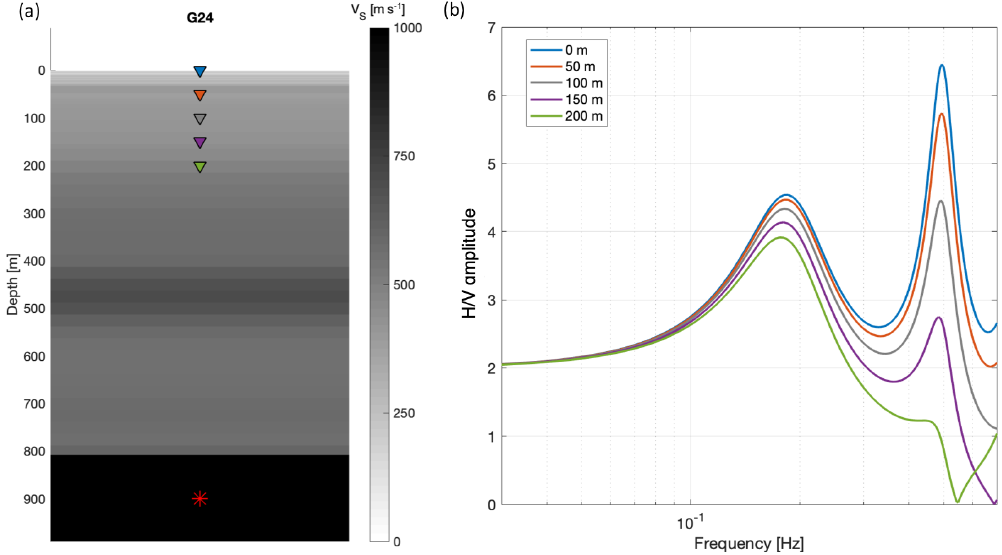
Figure 4. (a) Velocity profile from the Deltares-NAM model at station G24. The top 800m is made up of the NSG with much lower V S than the underlying Chalk Group. The coloured triangles denote instrumented depth levels, corresponding to the colours of the lines in (b) . The red star indicates the depth of the synthetic source. (b) Forward-modelled amplitude spectra (coloured lines) for a vertically incident shear wave, recorded at the five different depth levels. Both the fundamental mode and first higher mode of the entire sedimentary column can be seen. Also, waves resonate between the free surface and the high-velocity layer at 450m depth (Brussel Sand Member). The resulting fundamental mode interferes with the first higher mode of the entire NSG and results in the elevated peak just below